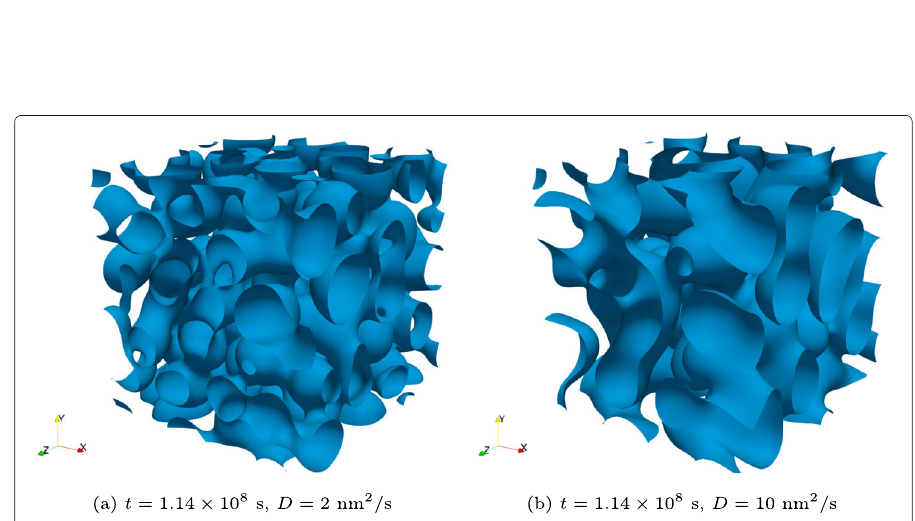
Fig. 2 Comparison of microstructure for varying diffusivity D , for initial conditions of Configuration 1. Simulation domain size is 72 μ m × 72 μ m × 72 μ